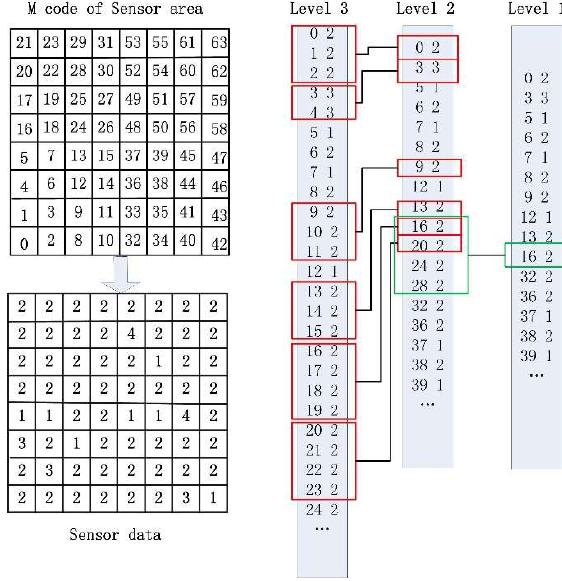
Figure 6. Data Figure 6. Data aggregation.